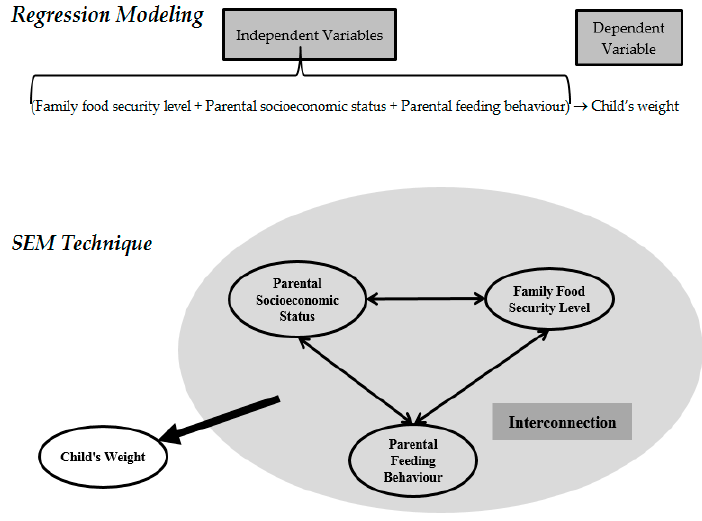
Figure 2. Structure of research variables in regression modeling with the SEM technique.